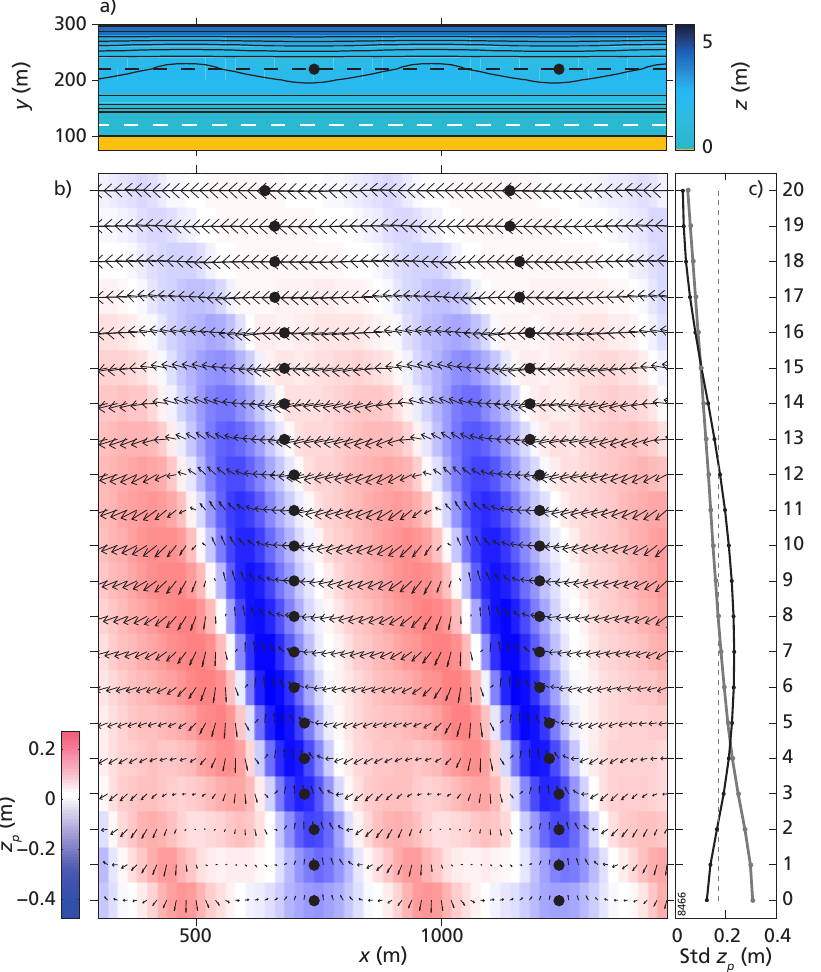
Figure 11. Model results, showing (a) the initial bathymetry, with isobaths (0 . 5m intervals) contoured in the background, (b) flow velocity U (arrows) and depth perturbations z p (colour) along the inner bar at y = 120m (white dashed line in (a) for all simulations after 2 days of simulation). (c) depicts the alongshore standard deviation of z p along the inner bar at y = 120 m (black) and the outer bar at y = 220m (grey), and the initial standard deviation of z p along the outer bar at y = 220m (dashed). The black dots in (a) and (b) indicate the alongshore positions of the outer-bar horns along y = 220m. Source: Price et al.